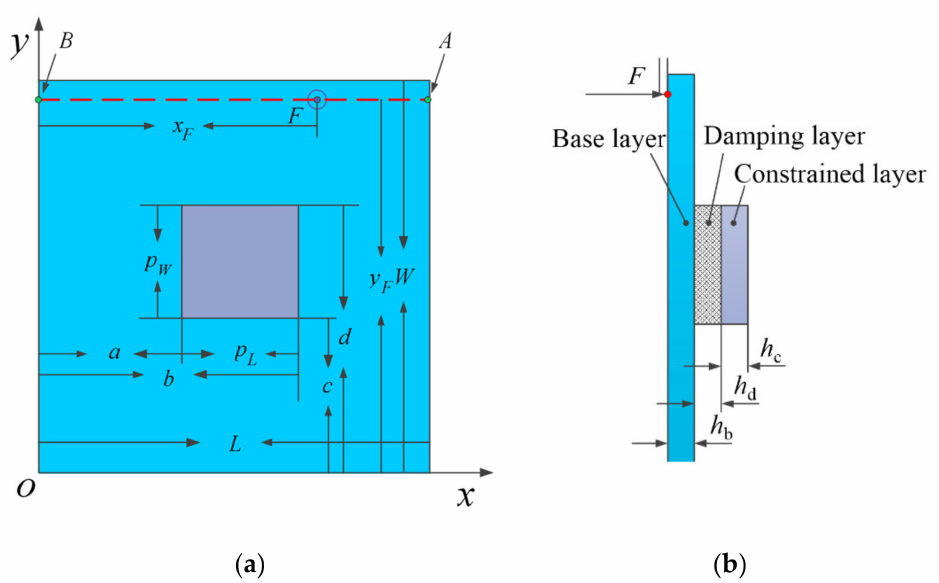
Figure 1. Model of system; ( a ) front view; ( b ) left